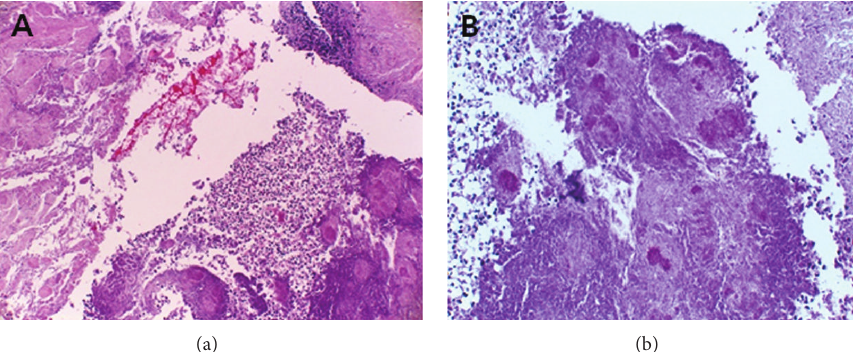
Figure 2: (a) Necrotic tissue with chronic nonspecific inflammation (H-E stain, × 100). (b) PAS stain reveals candida hyphae (periodic acid- Schiff stain, ×